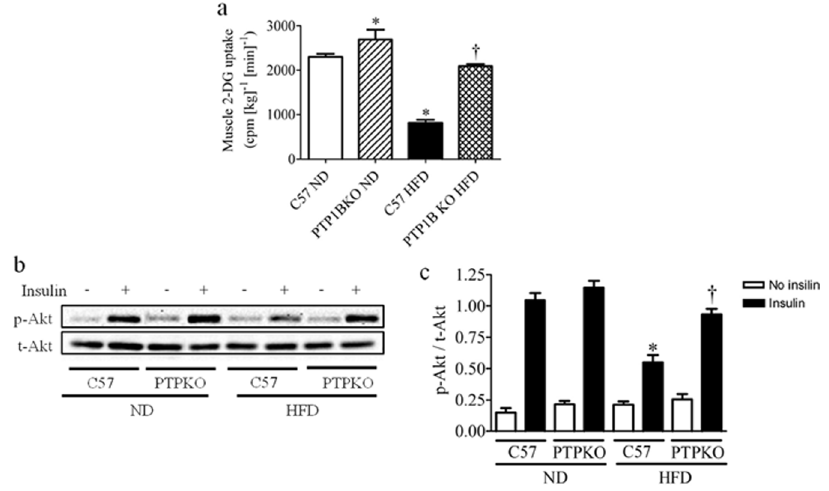
Figure 2. PTP1B deletion improves diet-induced insulin resistance and glucose uptake in skeletal muscle in mice. (a) [ 3 H]-2-deoxy- glucose-uptake assay (n=6); (b) representative Western blots and (c) densitometric analysis (n=6) of Akt phosphorylation in gastrocnemius muscles of the C57 or PTP1BKO mice received normal (ND) or high-fat content (HFD) diets for 20 weeks and challenged with insulin for 30 minutes. * p , 0.05 compared with C57 ND mice, { p , 0.05 compared with C57 HFD mice.